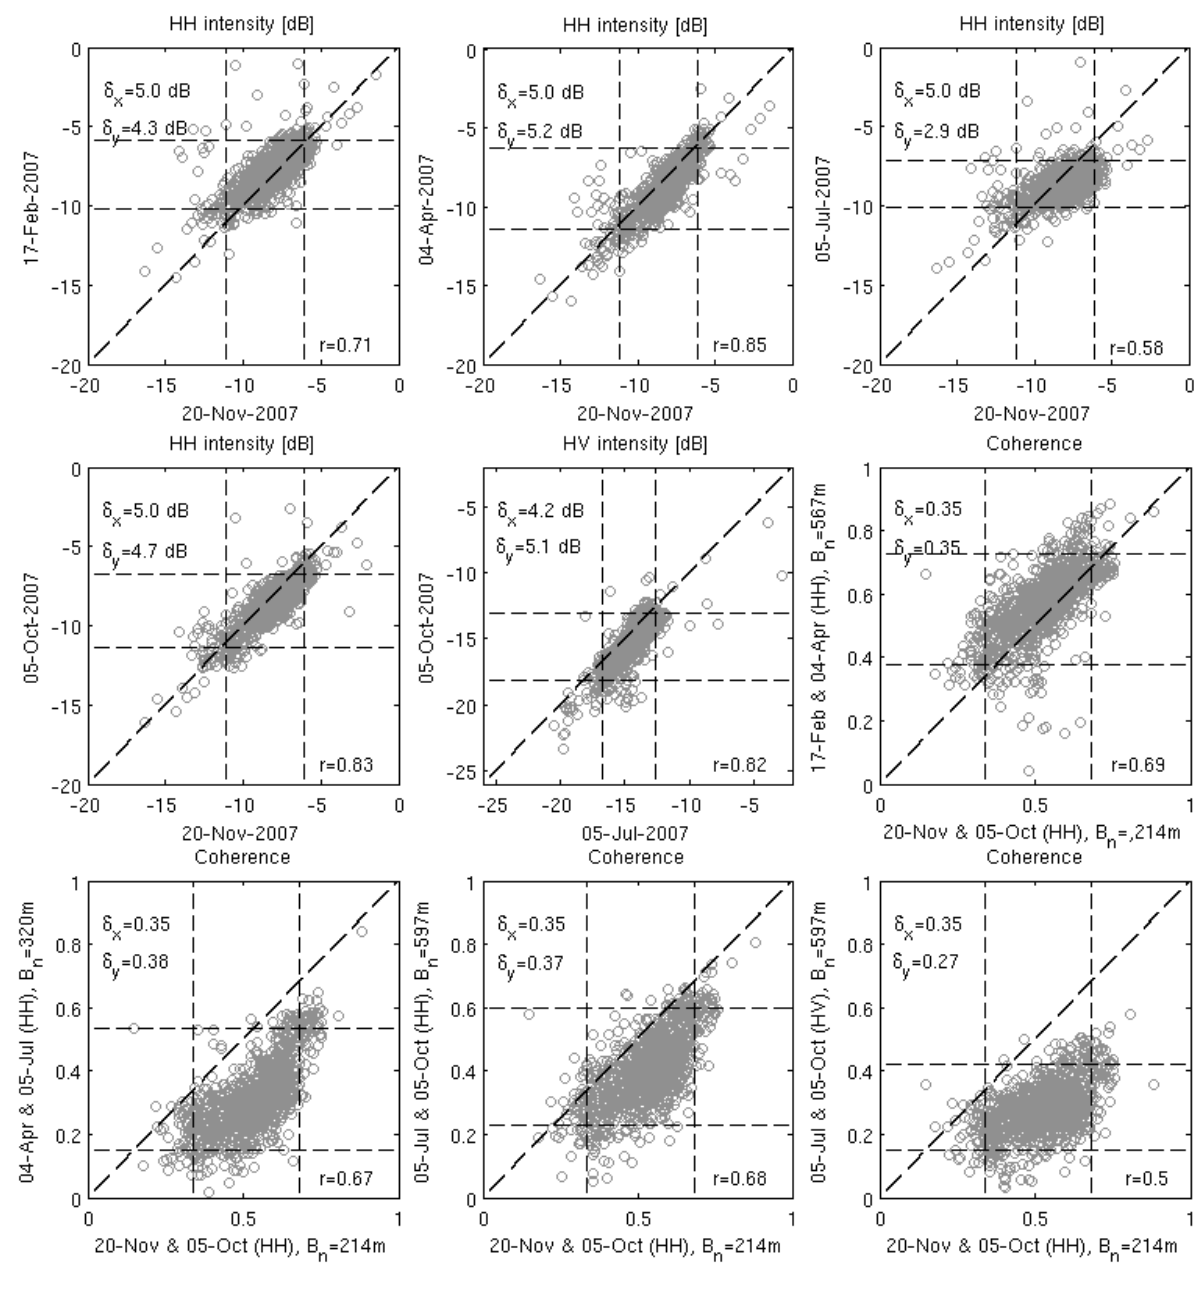
Figure 9. Multi-temporal consistency of HH/HV intensity and repeat-pass coherence at test site 2. Each circle represents the average intensity or coherence for a forest segment in two images. The dashed lines indicate the dynamic range, δ , for each image with the 5th and 95th